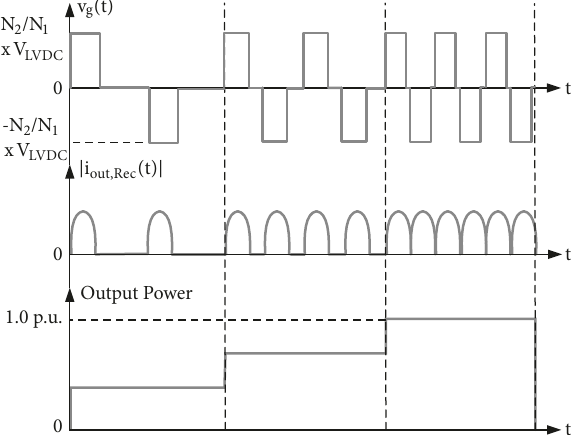
Figure 3: Frequency-depended power flow control of